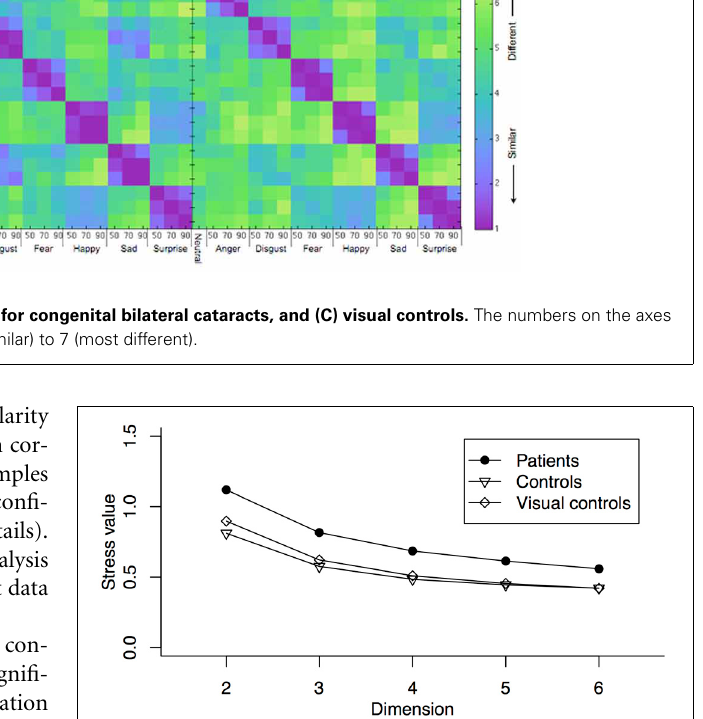
were within the range considered good (Kruskal and Wish,